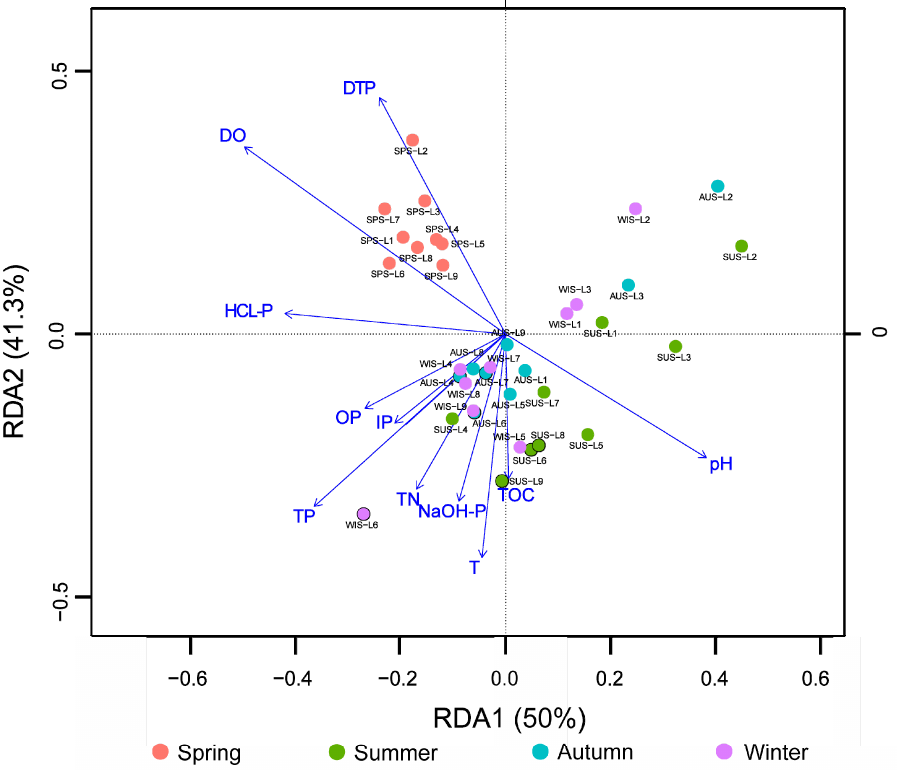
Figure 7. Redundancy analysis (RDA) analysis of bacteria phyla and physico-chemical factors in Sancha Lake.